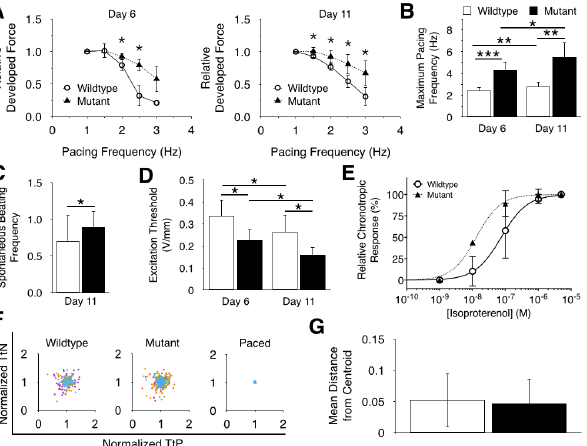
Fig 3. Electrical properties of of wild-type and BRAF-mutant hECTs. ( A ) Developed force versus frequency relationship of iPSC-derived hECTs at culture day 6 (left) and day 11 (right); ( B ) maximum pacing frequency of wild-type and mutant tissues; ( C ) spontaneous beating frequency; ( D ) The minimum voltage necessary for pacing for both tissues; ( E ) Relative chronotropic response to isoproterenol (normalized to baseline beating frequency) with fitted nonlinear regression model. ( F ) Twitch rate variability plots of each tissue type with a paced control for comparison. Each color represents a different tissue. ( G ) Quantification of twitch rate variability by the mean distance of each point on the twitch rate variability plots from each cluster centroid. Error bars represent standard error ( A ) or standard deviation ( B-G ) Open symbols and bars are wild-type hECTS (n = 7), filled symbols and bars are BRAF-mutant hECTs (n = 5). * p < 0.05, ** p < 0.01, *** p <